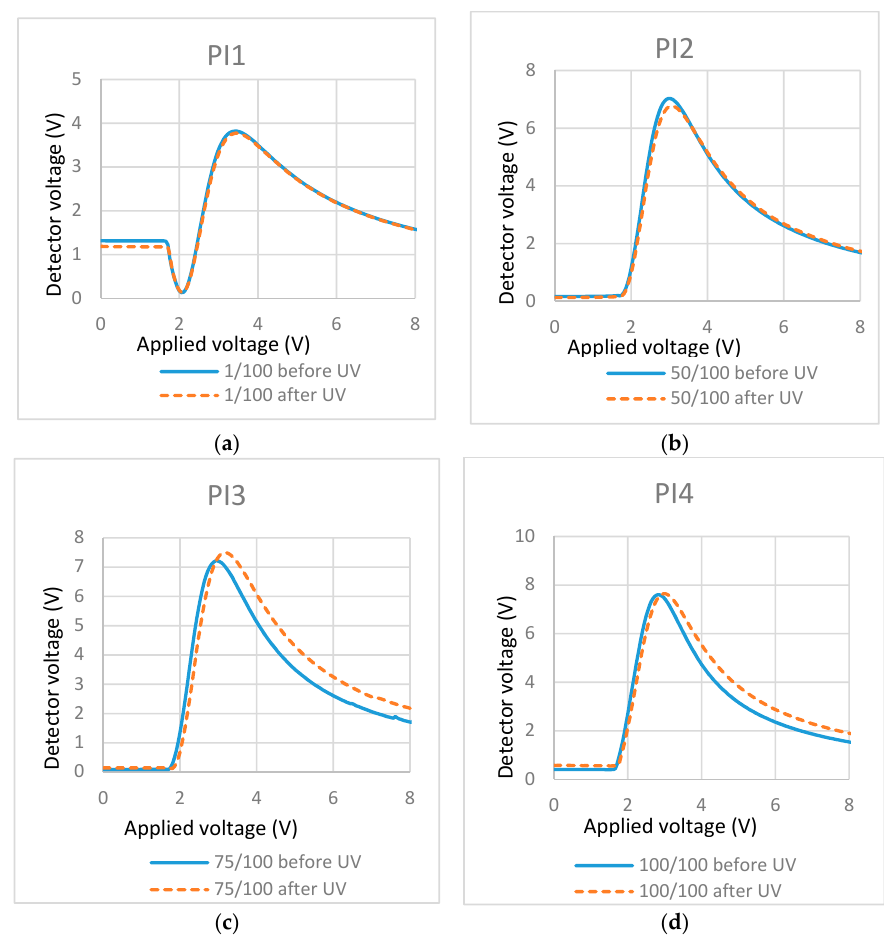
Figure 7. T/V curves of cells containing mixtures with different concentrations of photo-initiator (PI): ( a ) PI/RM = 1/100; ( b ) PI/RM = 50/100; ( c ) PI/RM = 75/100; and ( d ) PI/RM = 100/100.